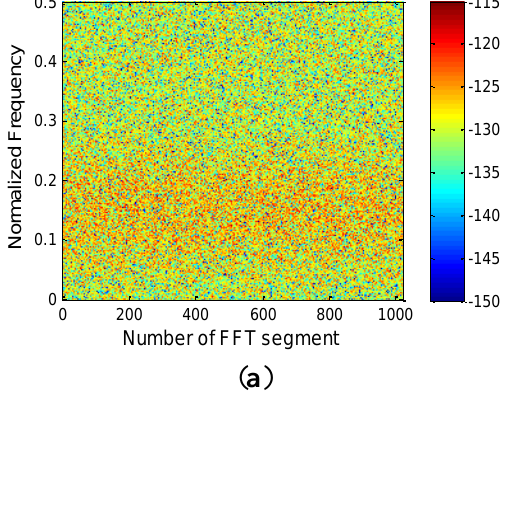
Figure 14. Smoothing Algorithm applied to a simulated PRN RFI contaminated radiometric signal. ( a ) RFI contaminated signal’s spectrogram, σ 2 Convolution of the spectrogram with a: ( b ) 5 × 5 Hann window; ( d ) 15 × 15 Hann window; ( f ) 25 × 25 Hann window; ( h ) 35 × 35 Hann window; RFI-mitigated spectrogram using the most suitable threshold for this INR and a smoothing of a: ( c ) 5 × 5 Hann window; ( e ) 15 × 15 Hann window; ( g ) 25 × 25 Hann window; ( i ) 35 × 35 Hann